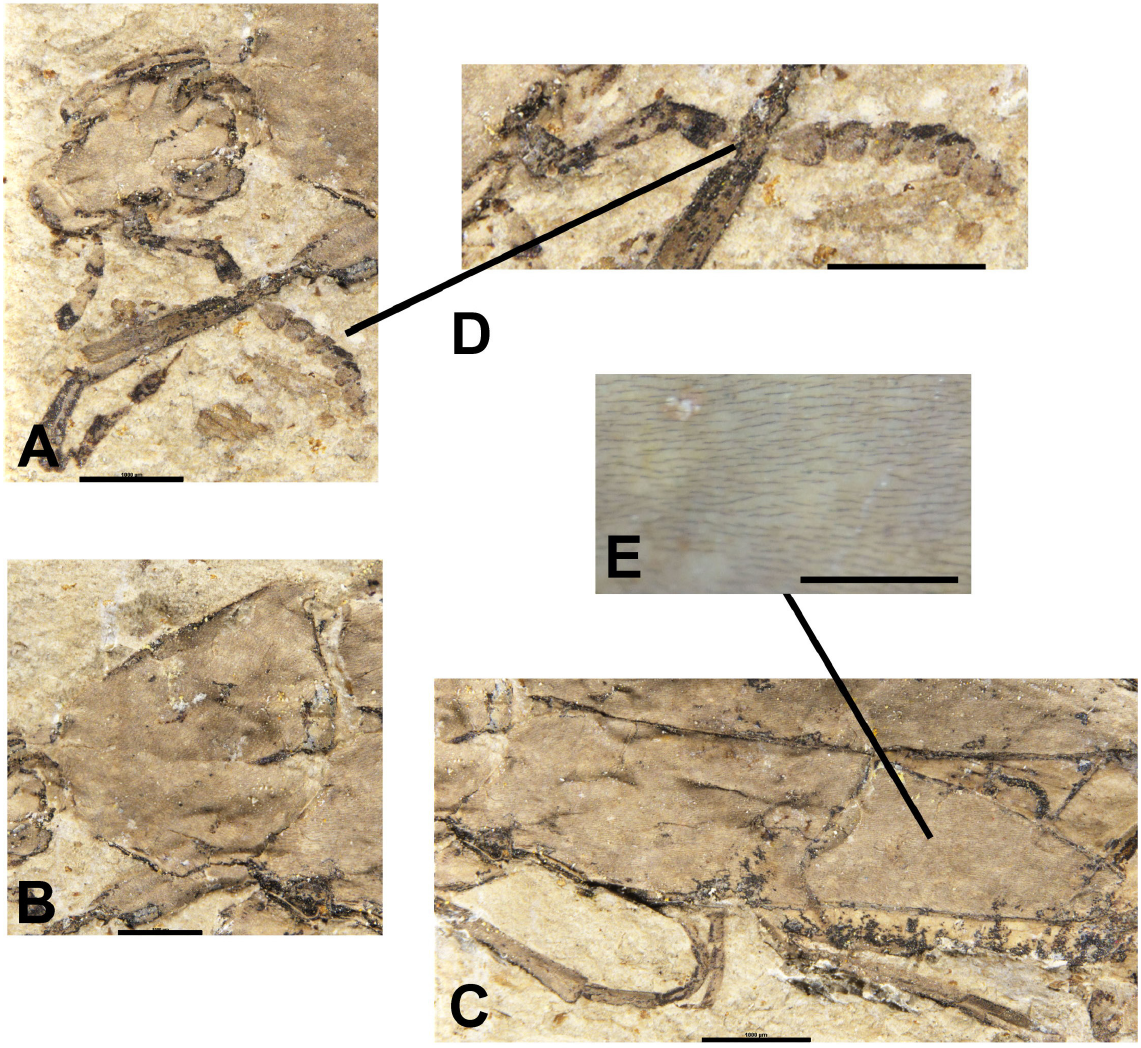
Fig. 3. Archaeoripiphorus nuwa Hsiao, Yu & Deng gen. et sp. nov., holotype. A . Head. B . Prothorax. C . Elytron. D . Antenna. E . Photograph of the surface of the body. Scale bars: A–C = 1.0 mm; D = 0.1 mm; E = 0.5 mm. The black arrows indicate the magnified